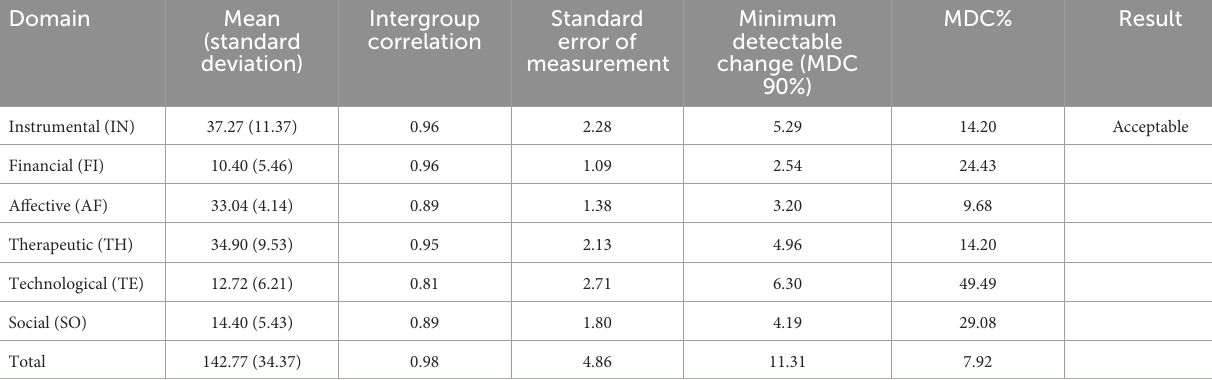
TABLE 6 The absolute stability of the questionnaire in the six domains.